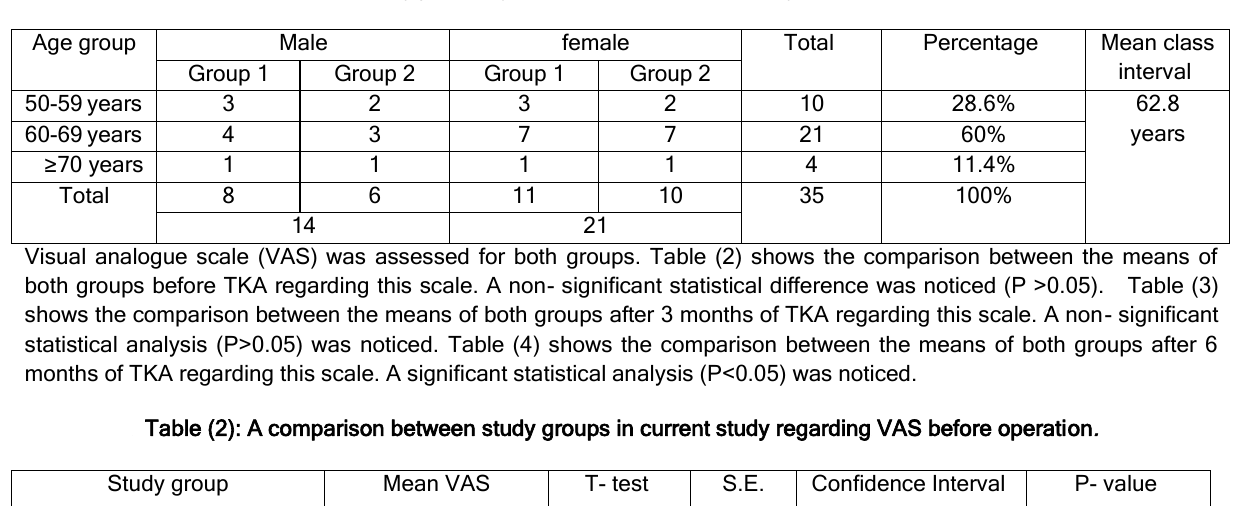
Table (1): The age distribution of current study patients